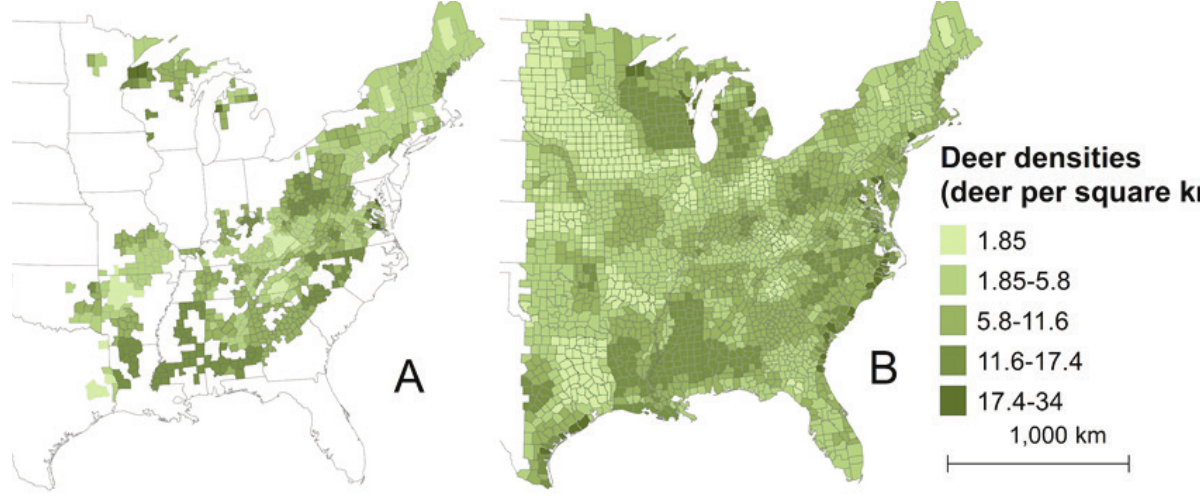
Figure 6. Deer densities (deer/km 2 ; Adams et al. 2009; Hanberry and Hanberry 2020) by county in eastern forests (A) and the eastern United States (B).